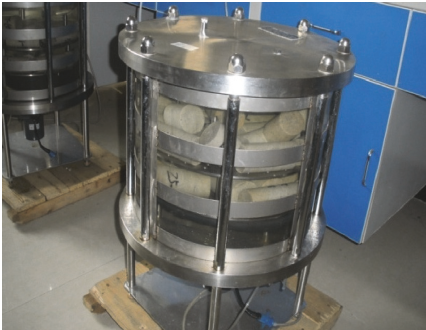
Figure 5: YRK-1 rock dissolution testing